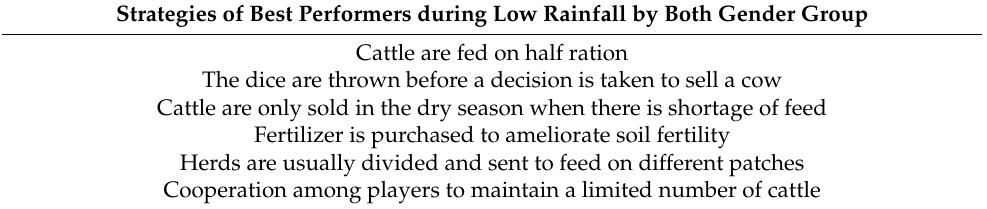
Table 2. Gender-specific coping strategies to cope with rainfall variability during the grazing game (n female games = 22; n male games = 22). Coping Strategy Men (%) Women